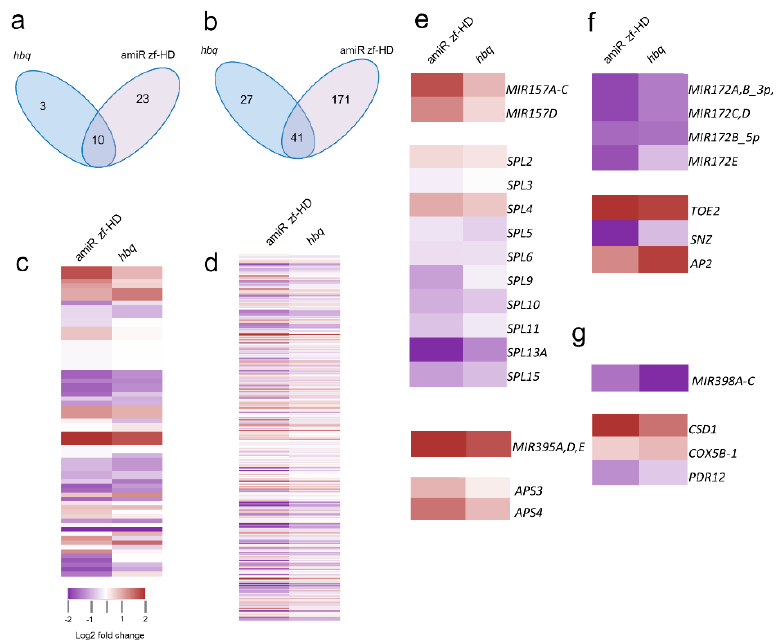
Figure 4. The ZF-HD–mediated miRNA gene regulatory network is enriched in FFLs. ( a – d ) smRNA profiling of miRNAs and miRNA target perturbation in zf-hd mutants in comparison with WT. ( a , b ) Venn diagram of DE downregulated miRNAs ( a ) and their targets ( b ). ( c ) Heat map of smRNA analysis in young flowers of amiR zf-HD and hbq, relative to WT. ( d ) Heat map of miRNA targets in young flowers of amiR zf-HD, and hbq , in comparison with WT. ( e ) Heat map of category I, which includes miR157 and miR395 and their targets (bottom). ( f ) Heat map of category II, which includes miR172 and their targets. ( g ) Heat map of category III, which includes mir398 and their targets. To systematically characterize miRNA-related biological network motifs in vivo, we integrated expression data from RNA-seq and smRNA data with transcriptional (ZF-HD TF and miRNA) and post-transcriptional (miRNA and miRNA target) [40] regulation data into a ZF-HD TF–related miRNA gene regulatory network, and used the integrated dataset to identify network motifs [41]. In comparison with a randomized network, the resultant network was enriched in type IV coherent FFLs ( p -value = 0.0001 for amiR zf-HD, and 0.0002 for hbq ) (Tables 1 and S4). Coherent FFLs have dynamic behaviors that